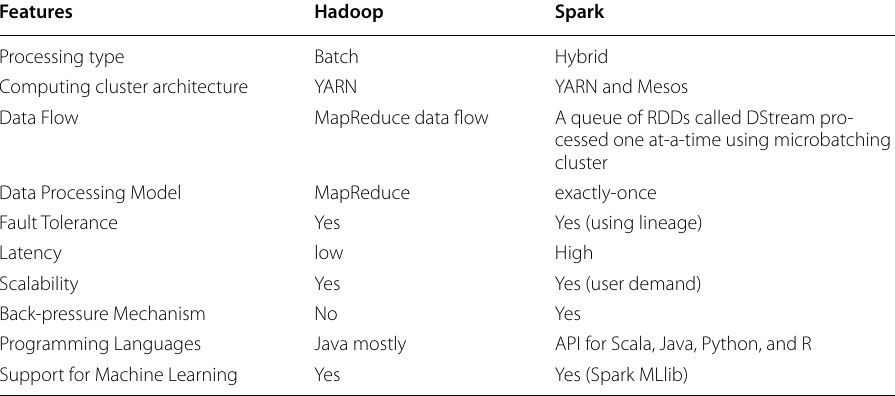
Table 4 Comparison among popular Non-spatial DB Framework